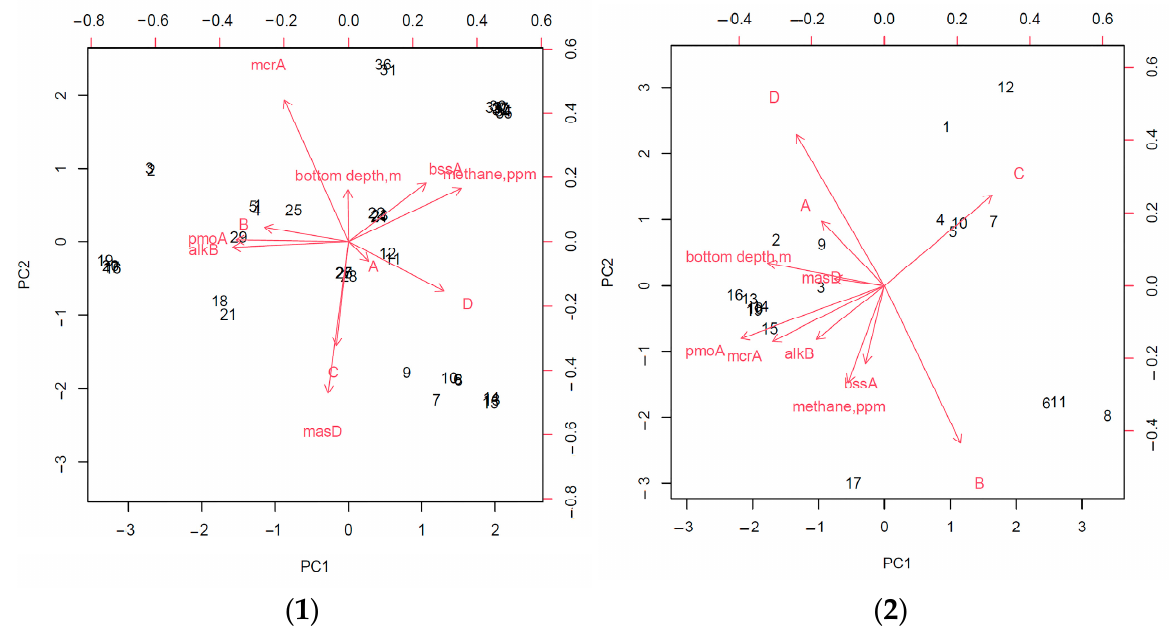
Figure 8. Relationships of the studied bioindicator signs in the gas-hydrate ( 1 ) and non-gas-hydrate ( 2 ) areas. (A) The degree of biodegradation of hydrocarbons under aerobic conditions; (B) the degree of biodegradation of hydrocarbons under anaerobic conditions; (C) frequency of isolation of strains; (D) frequency of isolation of strains capable of only aerobic degradation of hydrocarbons.